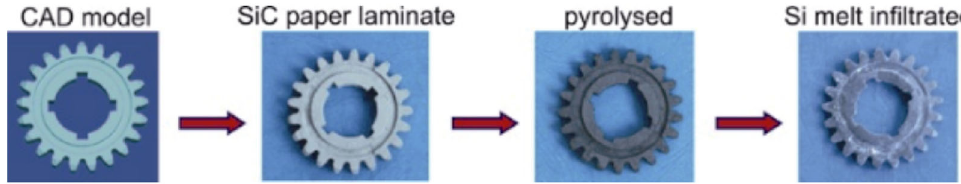
Fig. 14 SL fabrication process of Si–SiC micro gears. Reproduced with permission from Ref. [114], © WILEY-VCH Verlag GmbH & Co. KGaA